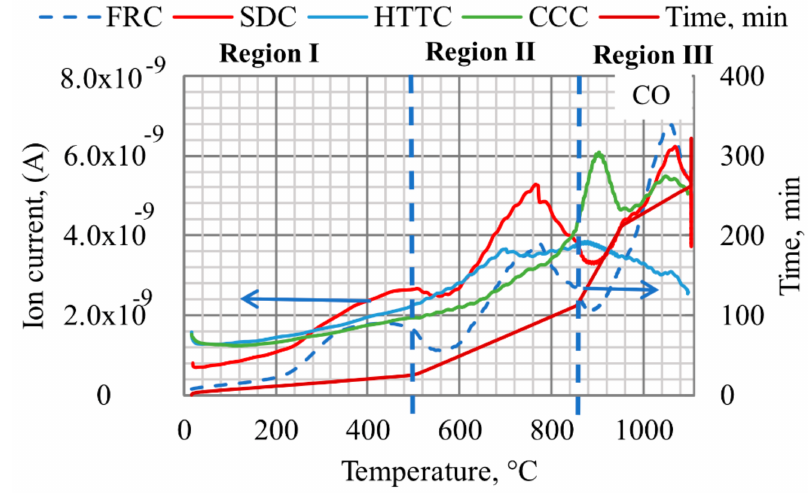
Figure 8. O ff -gas analysis of CO for di ff erent types of bio-coal containing composites